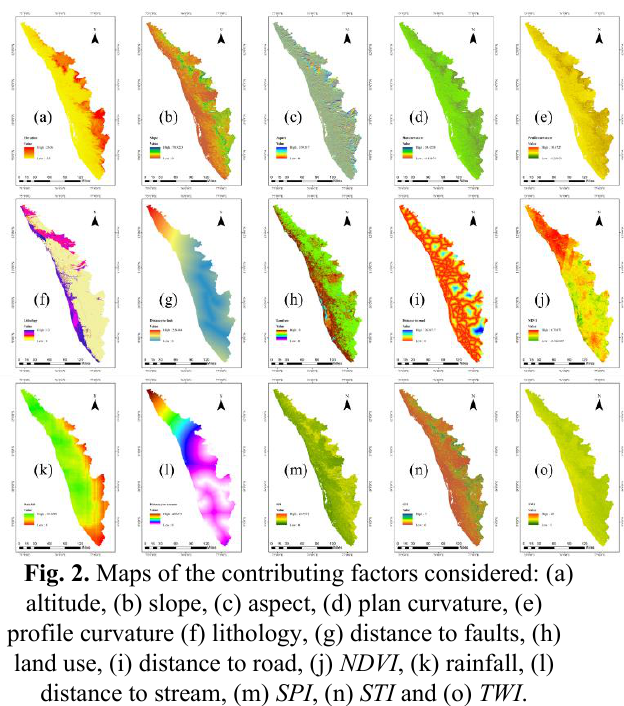
Fig. 2. Maps of the contributing factors considered: (a) altitude, (b) slope, (c) aspect, (d) plan curvature, (e) profile curvature (f) lithology, (g) distance to faults, (h) land use, (i) distance to road, (j) NDVI , (k) rainfall, (l) distance to stream, (m) SPI , (n) STI and (o) TWI